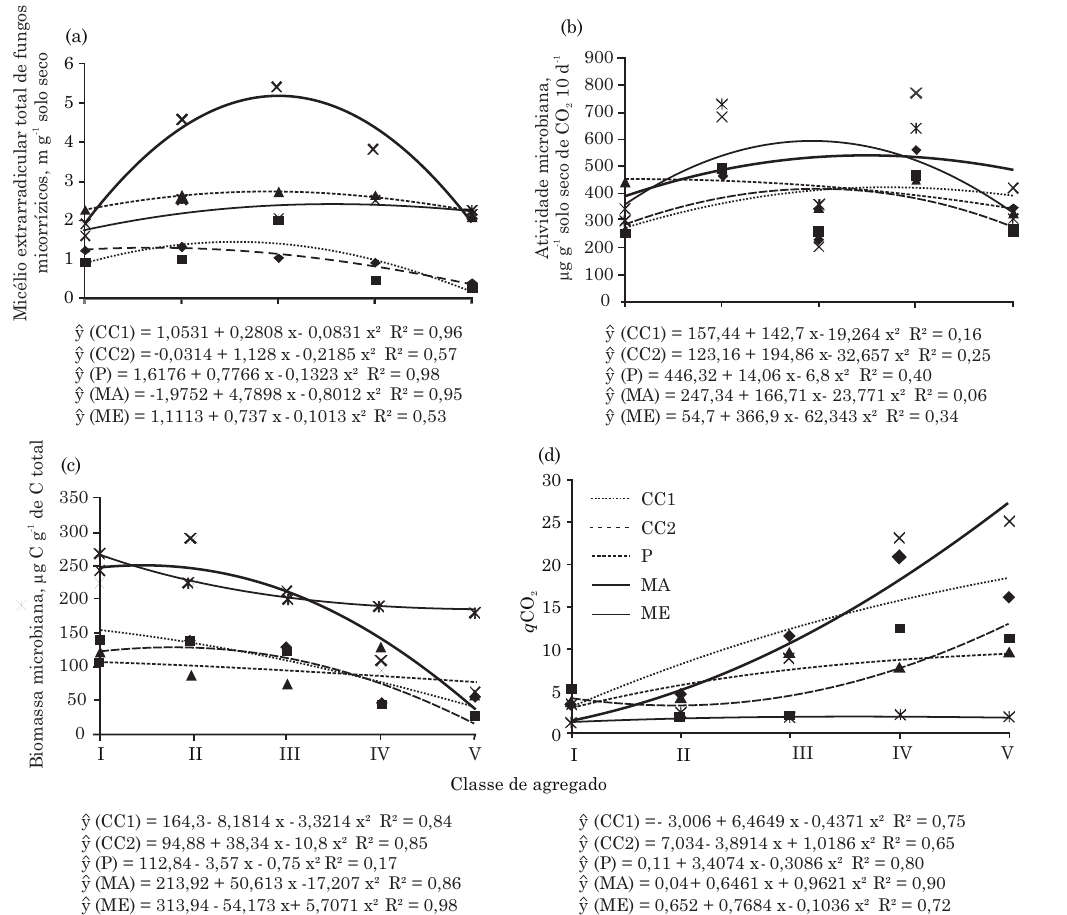
Figura 1. Equações de regressão do comportamento de atributos microbianos nas classes de agregado de amostras de solo, nos tipos de uso da terra. CC1: cultivo convencional com cenoura; CC2: cultivo convencional com abóbora; P: pastagem; MA: mata com araucária; e ME: mata de eucalipto. Classes de agregados: I: 4,00-2,36 mm; II: 2,36-1,18 mm; III: 1,18-0,60 mm; IV: 0,60-0,30 mm; e V: 0,30-0,15